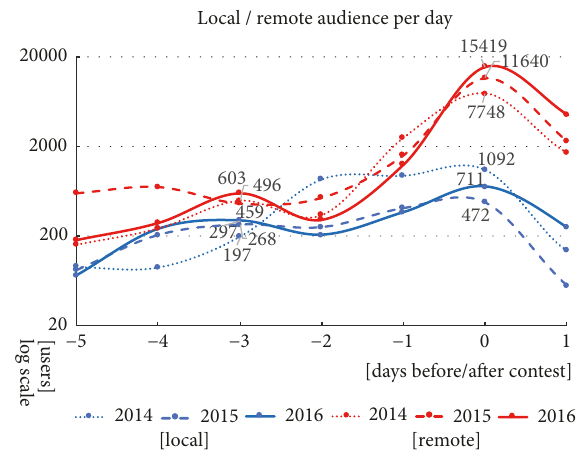
Figure 19: Daily remote/local audience load for the 2014-2016